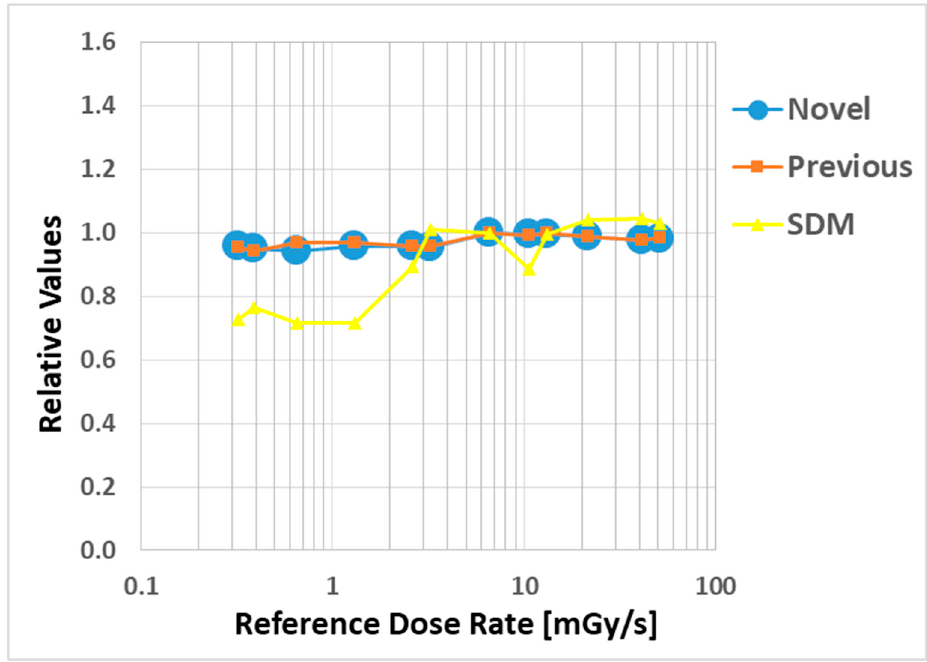
Figure 7. Dose rate dependence compared with the novel, previous sensors, and SDM.